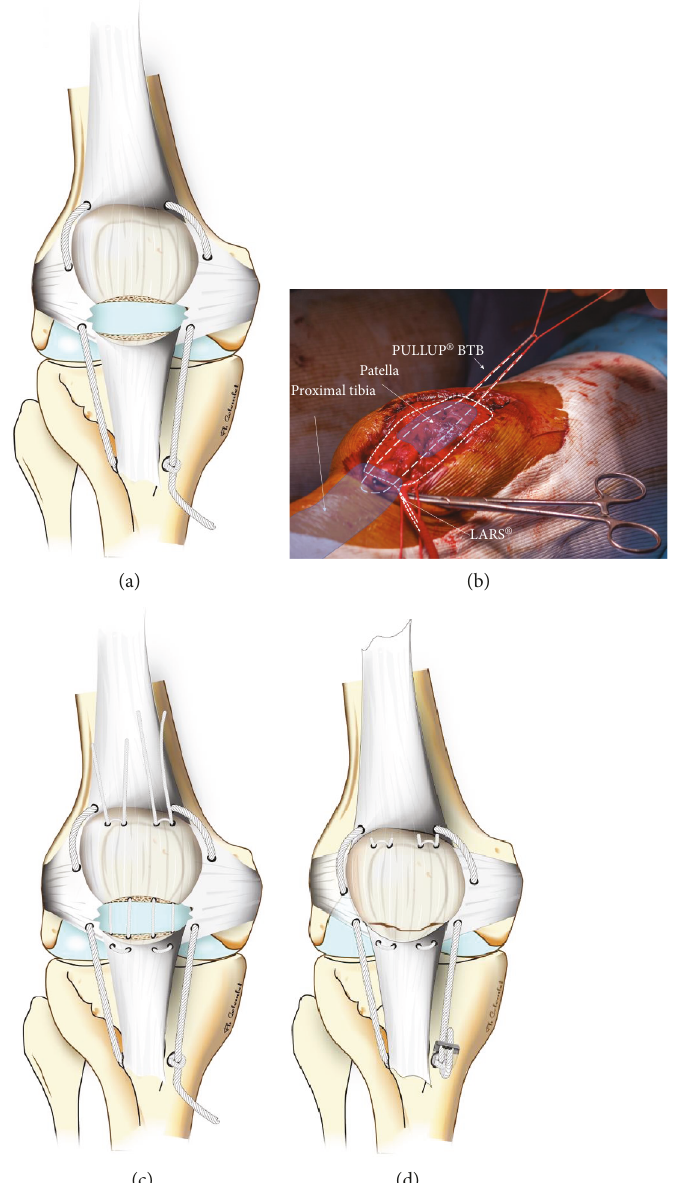
Figure 3: Pictures of the surgical steps. (a) With the arti fi cial ligament in place. (b) Perioperative view with the arti fi cial ligament and one adjustable loop. (c) With the arti fi cial ligament and the two adjustable loops. (d) The fi nal step when the arti fi cial ligament and the loops are tightened. A staple is placed to secure the arti fi cial